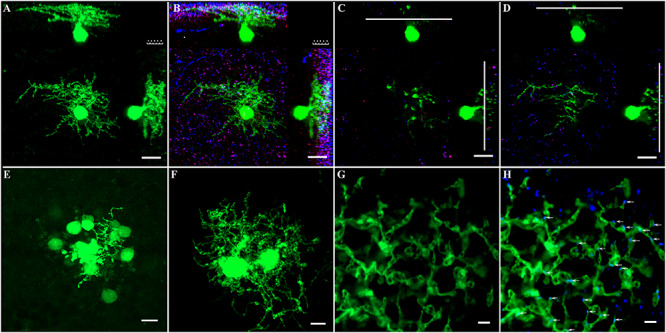
Phospho-Ser293 and monoclonal anti-Cx36 antibody labeled prominently in IPL. (A) GFP-labeled AII amacrine cell in Fam 81 mouse retina was targeted and injected with Neurobiotin to show single AII AC’s soma–dendritic morphology in Z stack by 3D reconstruction image. (B) AII AC double labeled with phospho-Ser293 (red) and monoclonal anti-Cx35/36Cx36 (blue) puncta located predominately on the arboreal dendrites (blue) strata three to five layers. (C) Single layer of AII AC in the lobular layer. (D) Single layer of AII AC in the arboreal dendrite layer. Phospho-Ser293 puncta are also colocated on the arboreal dendrites (red) strata layer 5. (E) Coupled AII ACs displayed with Neurobiotin injection. Only cell bodies coupled via gap junction showed clearly. (F) To show the dendritic gap junctional coupling in AII ACs, two nearby AII ACs were injected with Neurobiotin. (G) Dendrites between the two nearby AII ACs injected with Neurobiotin in the S5 layer. (H) Labeled with monoclonal anti-Cx35/36 (blue). Cx36 puncta localized on dendrites of AII ACs (white arrows). Scale bar: (A–D) 10 μm, (E,F) 5 μm, (G,H) 2 μm.